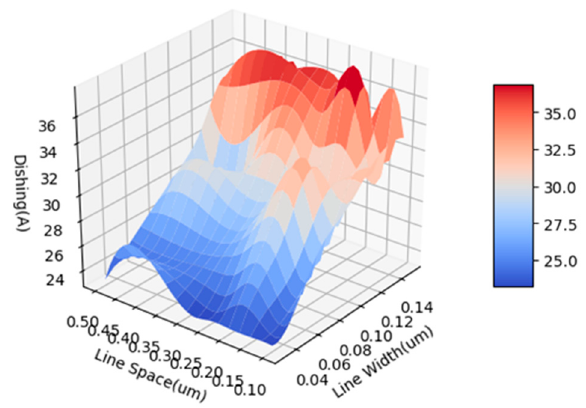
Figure 5. The dishing defects of the SEM data.